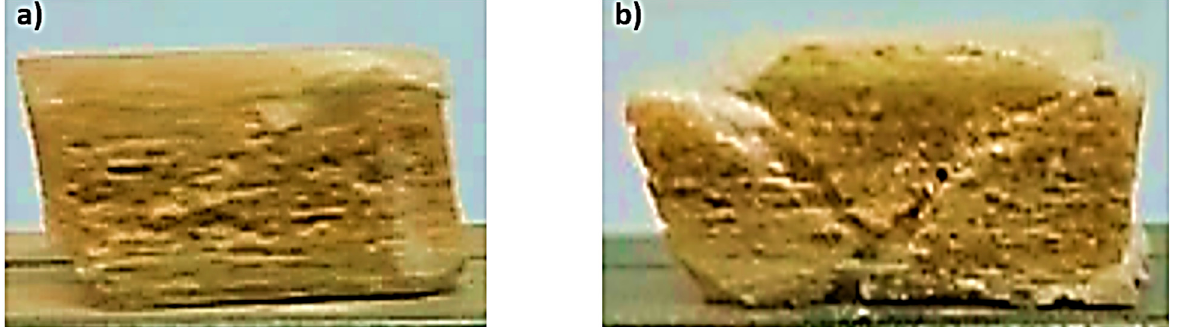
Figure 12. Compression failure mode; ( a ) transverse, ( b ) longitudinal.